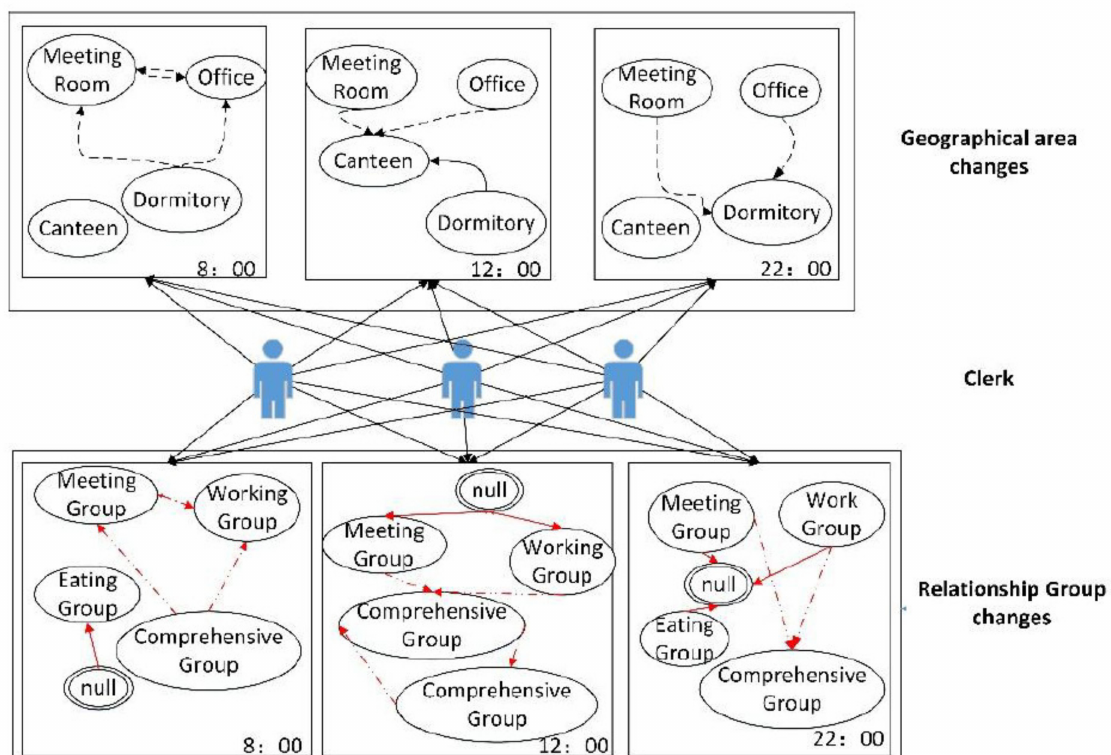
Figure 3. Action trajectory map based on time-varying relational